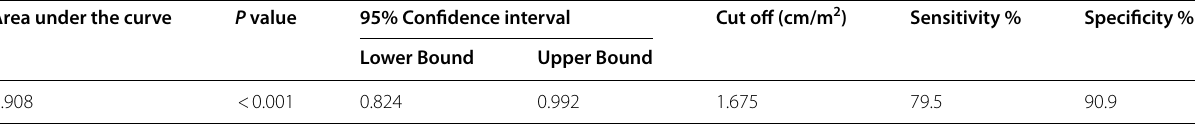
Table 10 Cut off values for male quadriceps thickness index Area under the curve P